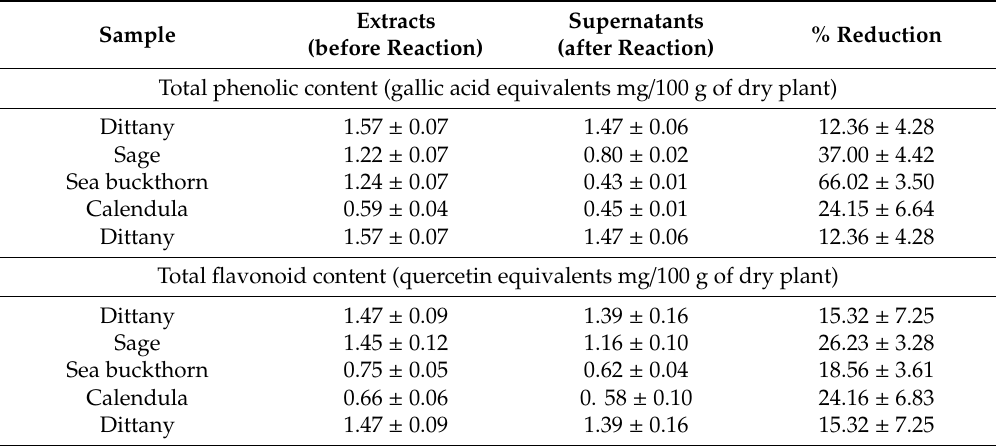
Table 3. Total phenolic and flavonoid content and antioxidant activity of AgNPs and the extracts before and after the AgNPs synthesis (mean values ±